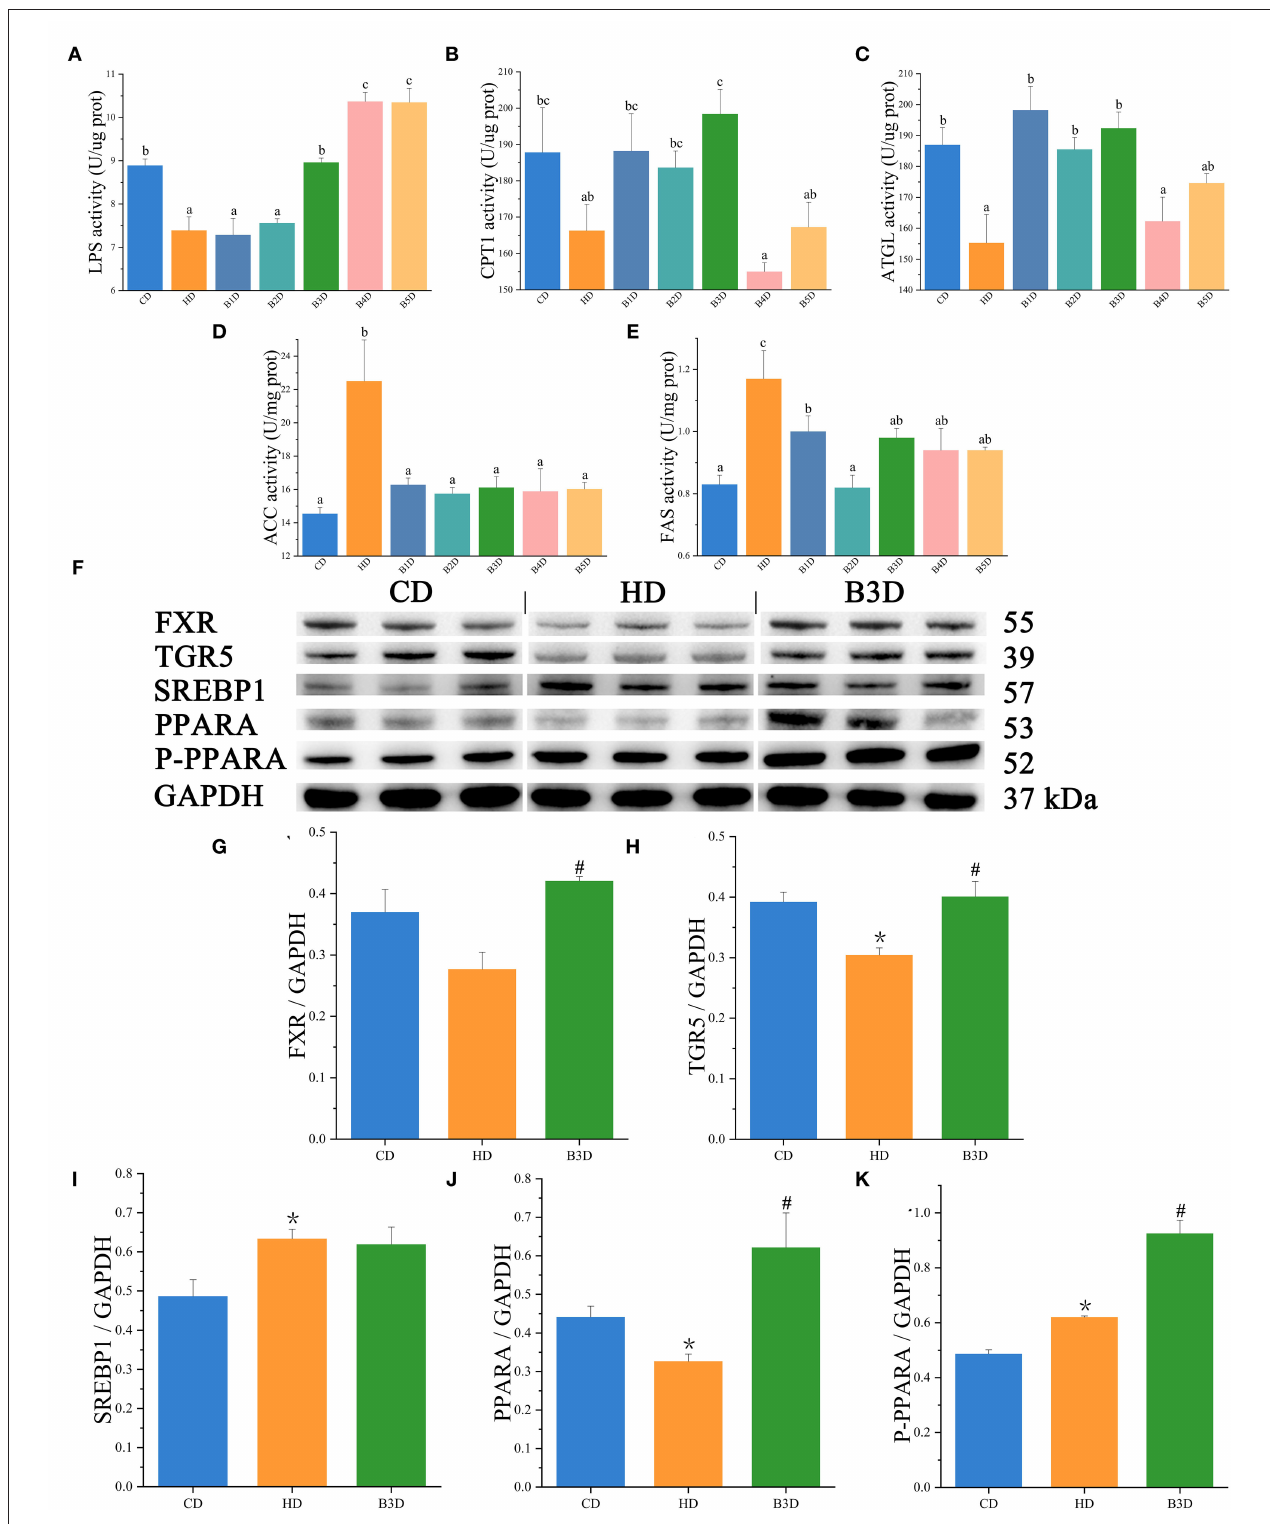
FIGURE 6 | The activities of enzymes and expression of proteins in the liver samples. (A–E) the activities of LPS (lipase), CPT1 (carnitine palmitoyltransferase 1), ATGL (triglyceride lipase), ACC (acetyl-CoA carboxylase), and FAS (fatty acid synthase) in fish ( n = 6). (F) the Western Blot analysis of SREBP1 (sterol responsive element binding protein 1), PPARA (peroxisome proliferator-activated receptor alpha), P-PPARA, and GAPDH in the liver ( n = 3). (G–K) the relative quantification of FXR, TGR5,